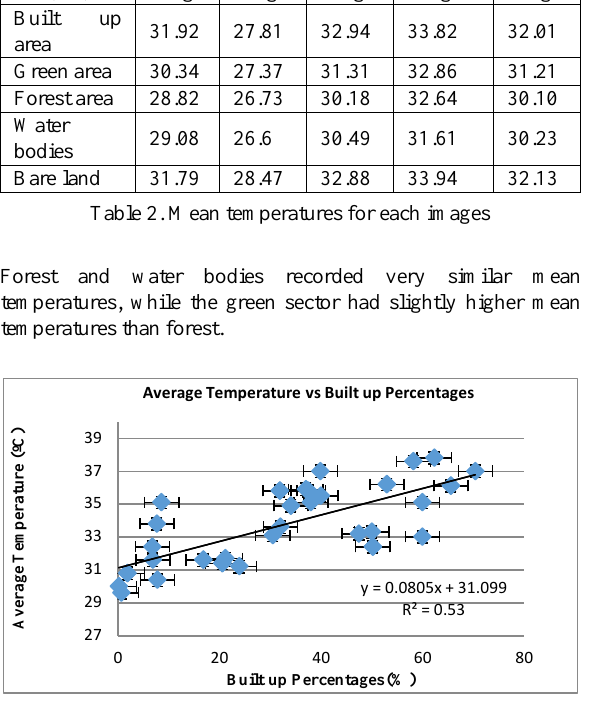
Figure 2. The correlation coefficient of the average temperature and the built up